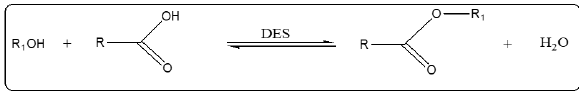
Figure 8: Esterification reaction catalyzed by DES. f f See De Santi et al. [55] for detailed reaction components and